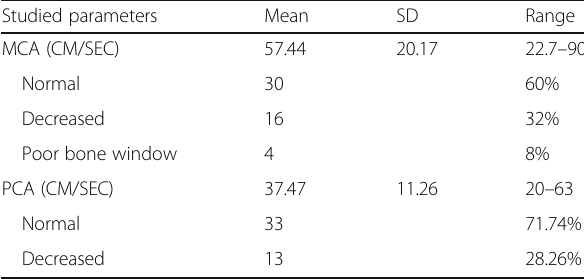
Table 2 Descriptive parameters of transcranial